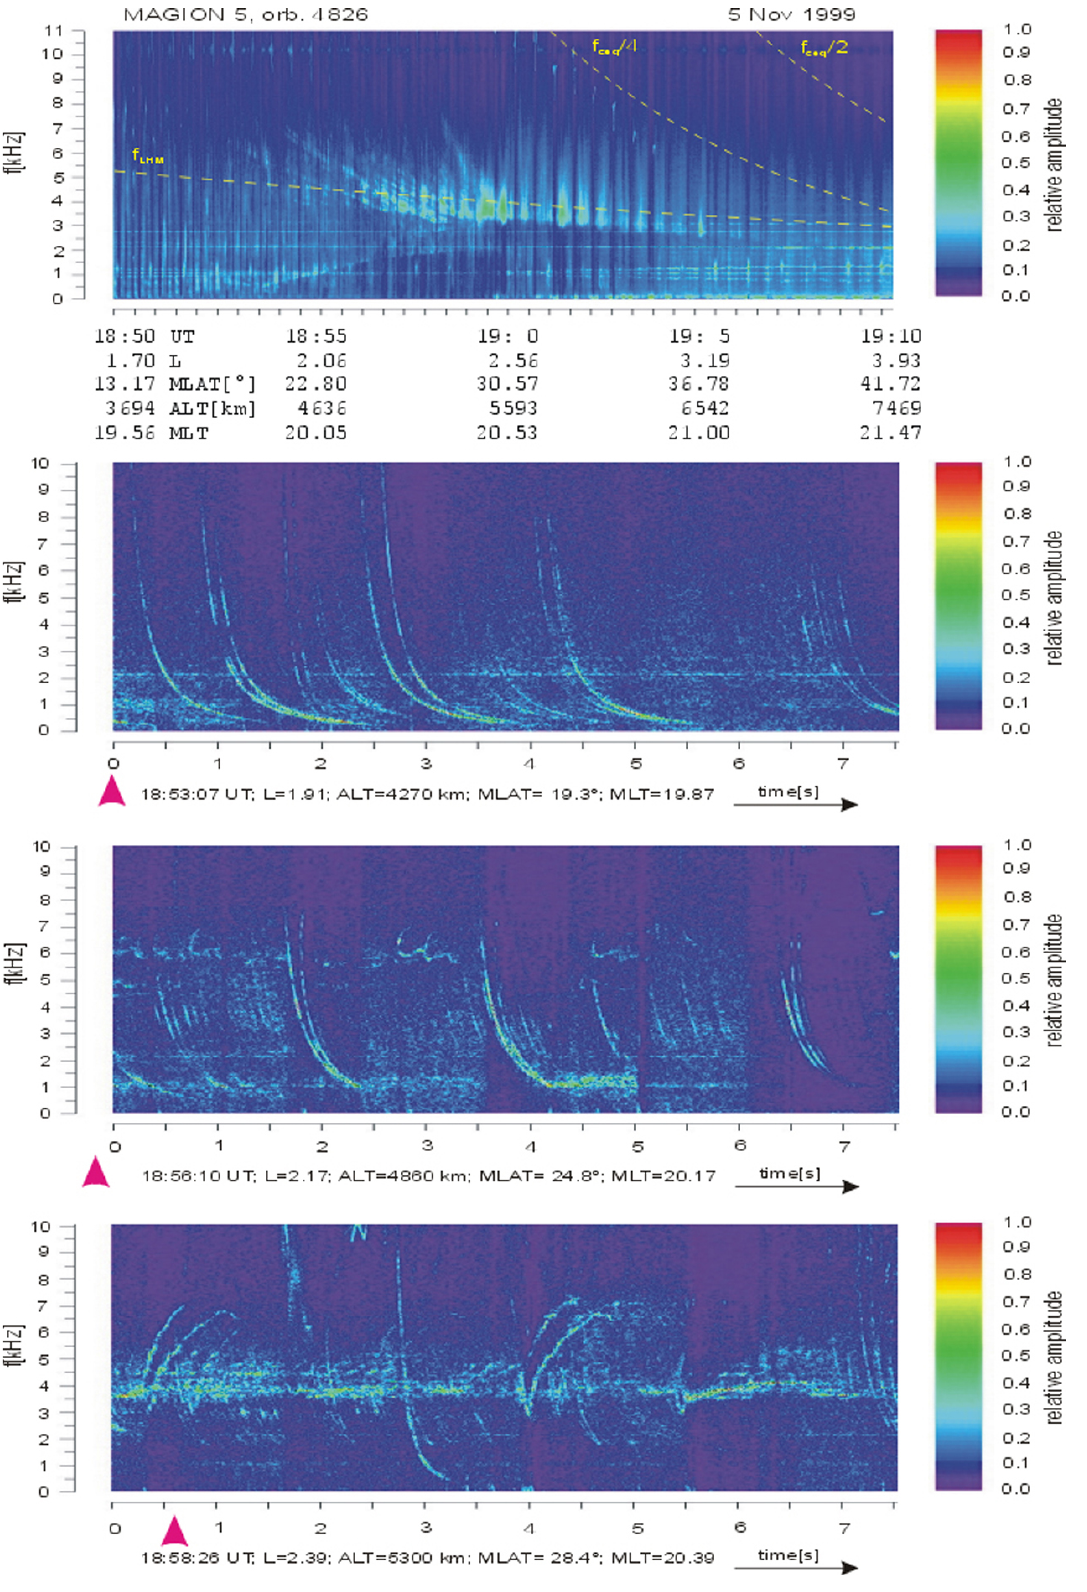
Fig. 8. Overview and detailed spectrograms along MAGION 5 orbit